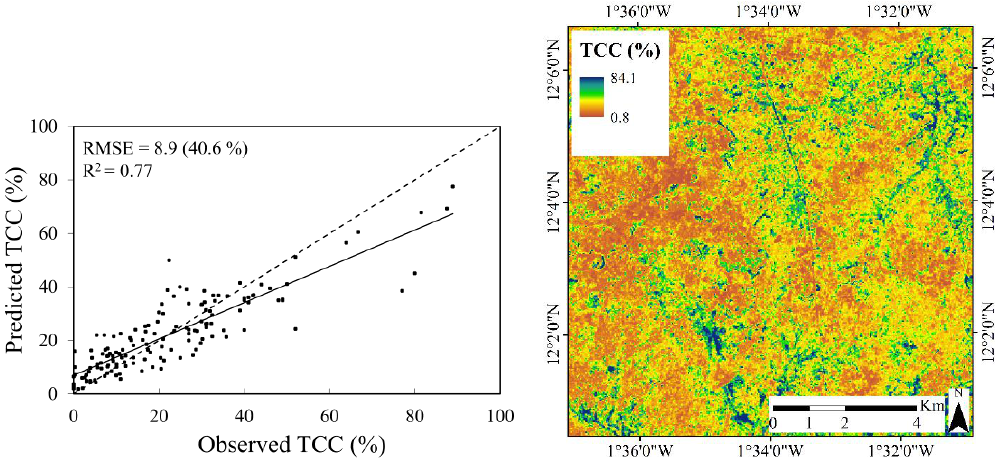
Figure 6. Relationship between observed and predicted tree canopy cover (TCC) using multi-temporal imagery and the reduced model. The dashed 1:1 line shows an optimal model fit. The map of TCC to the right was derived from the most accurate model ( i.e. , multi-temporal imagery and reduced